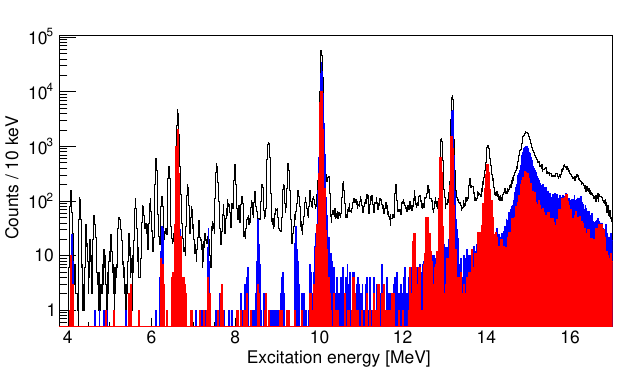
Figure 3. An excitation-energy spectrum of states in 48 Cr following the 50 Cr( p , t ) 48 Cr reaction [7]. The hollow black spectrum corresponds to states in 48 Cr while the blue and red spectra show 12 C( p , t ) 10 C and 16 O( p , t ) 14 O reactions from carbon and Mylar targets,